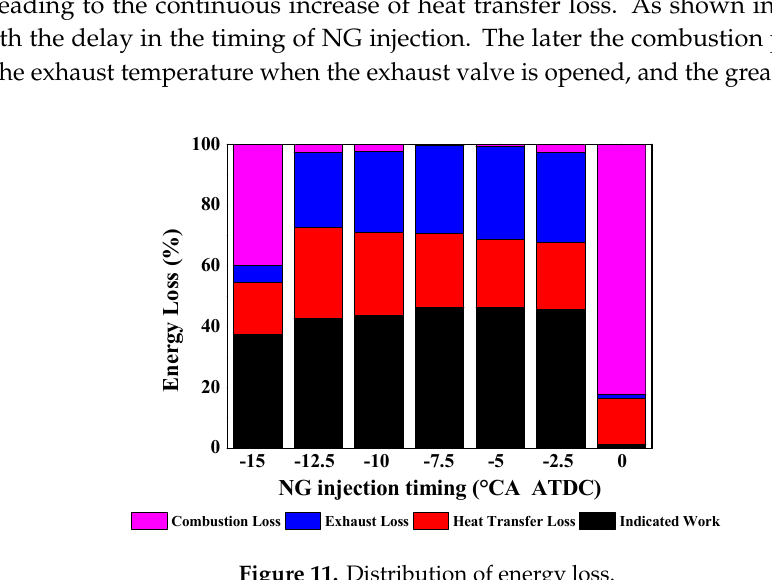
Figure 11. Distribution of energy loss.